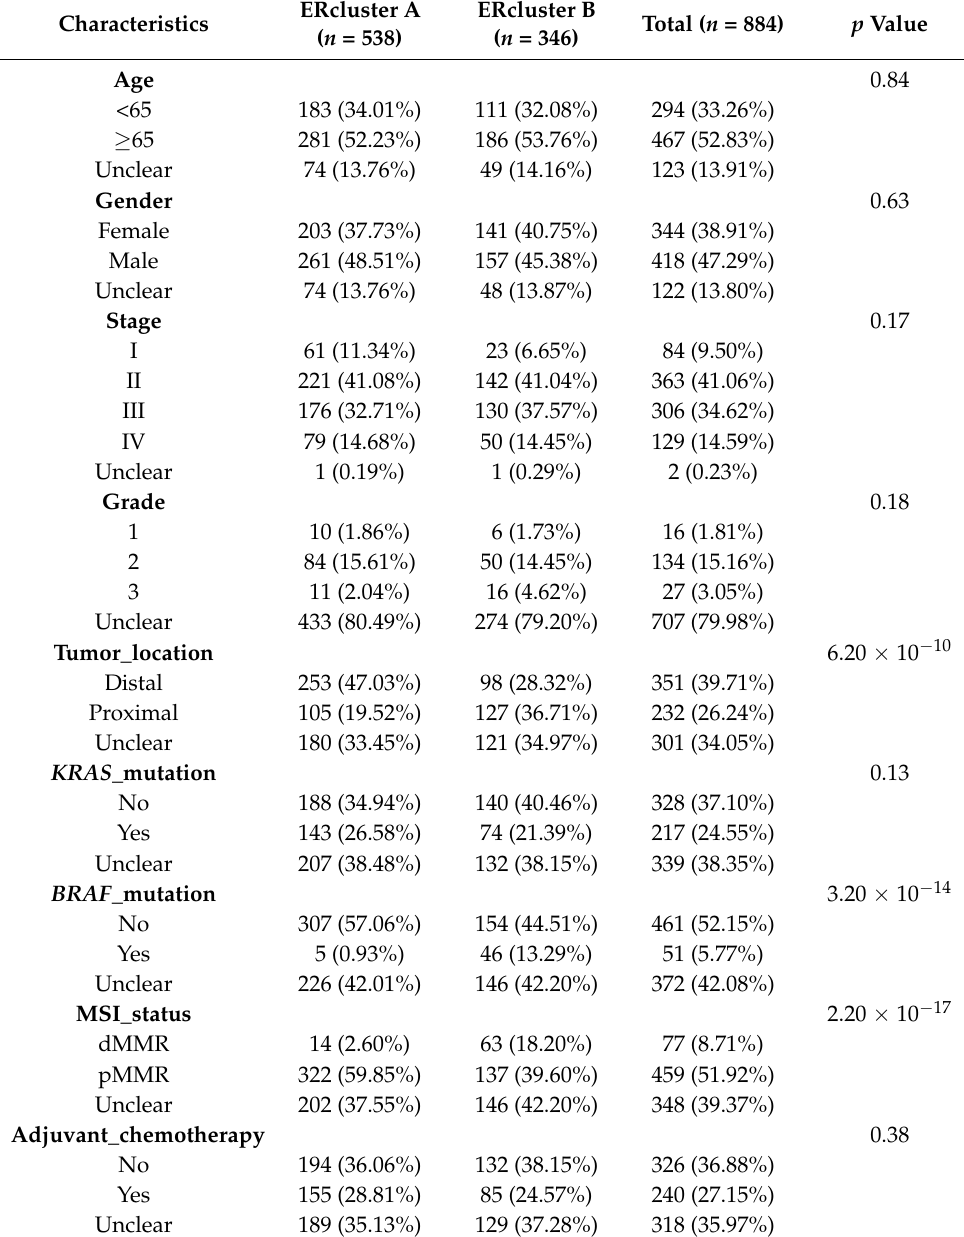
Table 2. Characteristics of CRC patients in ERcluster A and ERcluster B in GEO datasets.